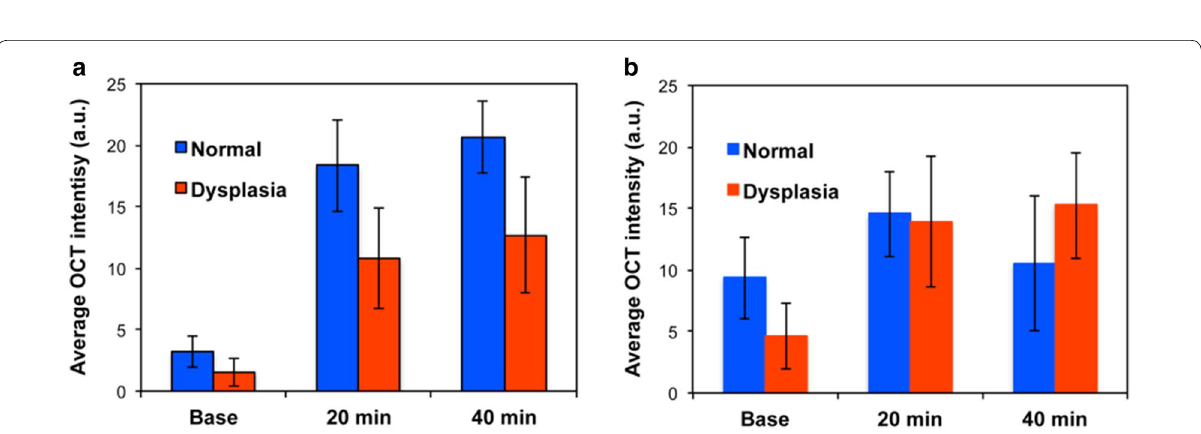
Fig. 8 Quantification of OCT results. Average SD‑OCT intensity for a acid‑degradable Au–NCs and b non‑acid degradable Au‑NCs after before (base) and after multi‑modal delivery method (20 and 40 min) in 5 different dotted SD‑OCT image regions in Figs. 7 and Additional file 1: Figure